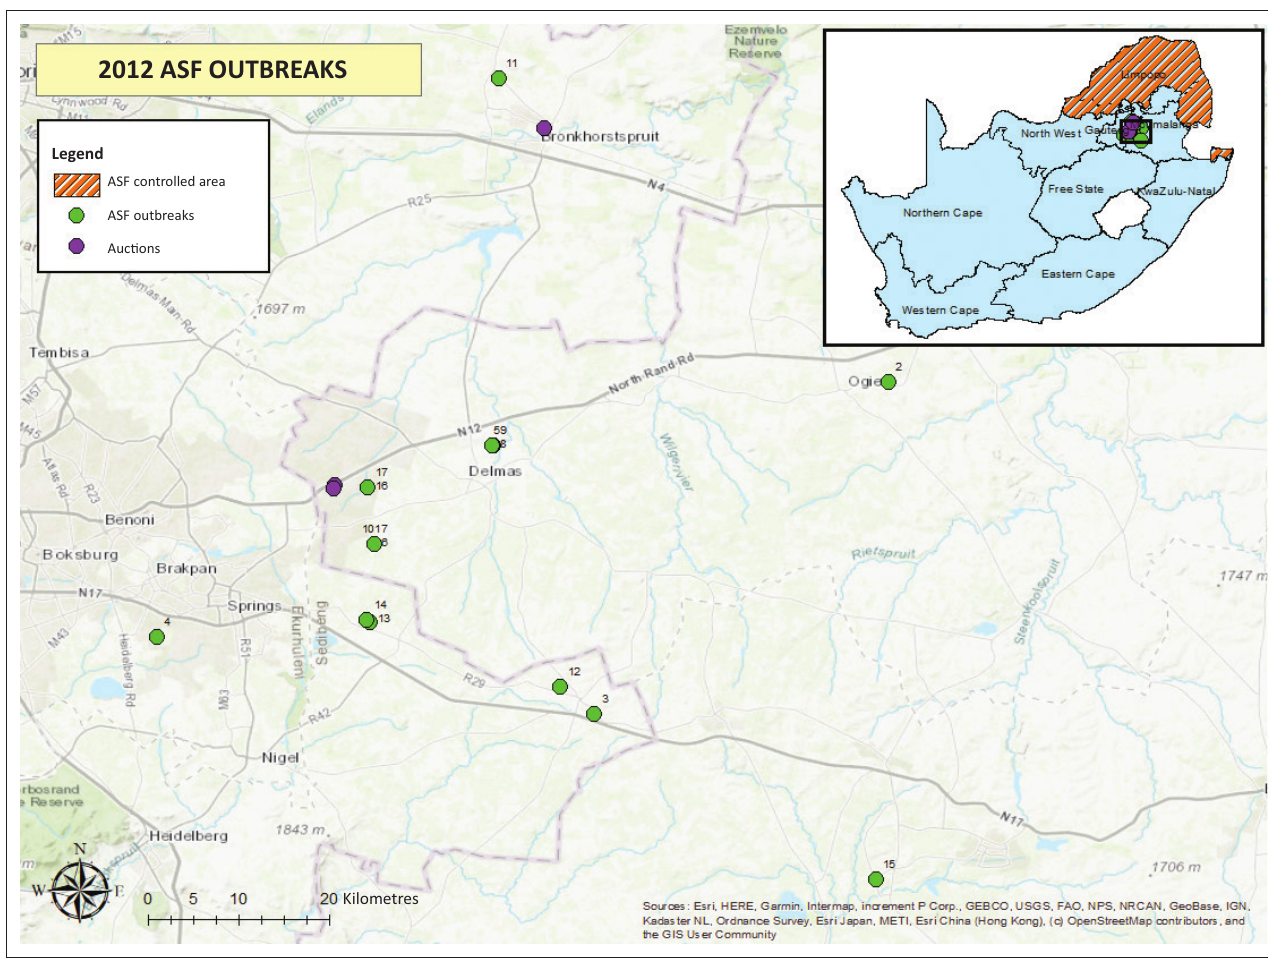
FIGURE 1: Map of locations involved during the 2012 African swine fever